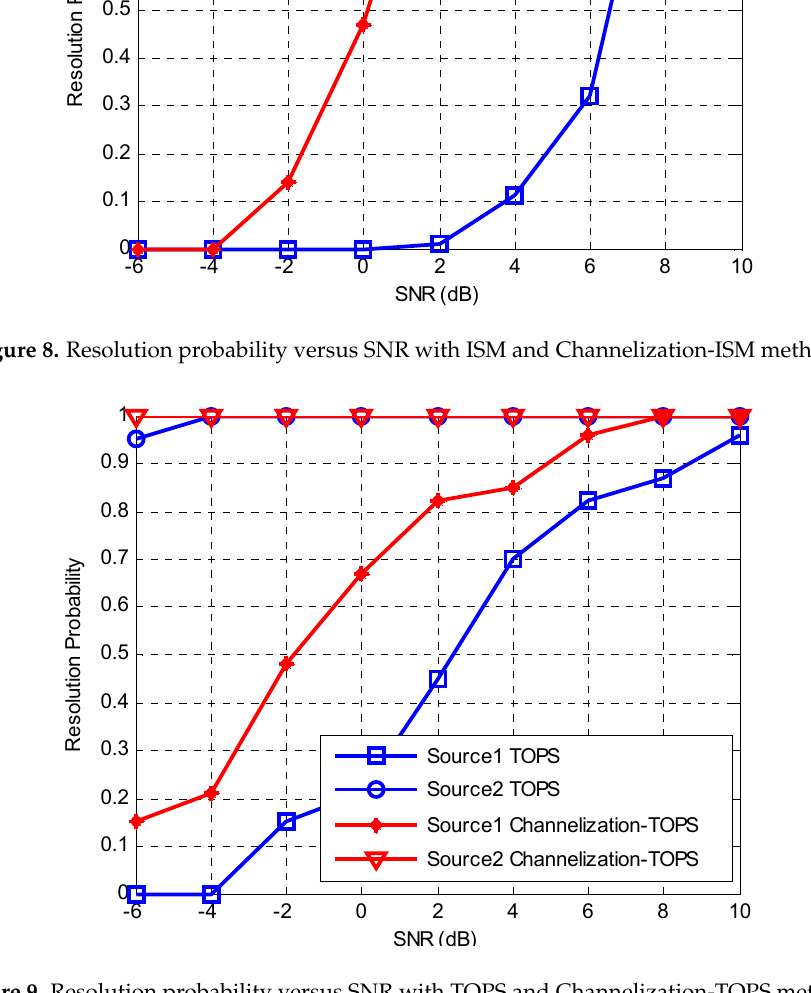
Figure 8. Resolution probability versus SNR with TOPS and Channelization-TOPS method.